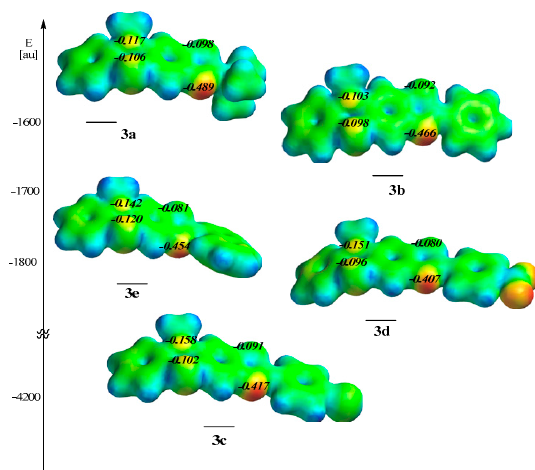
Figure 5. Molecular electrostatic potential surface (EPS) plots of TAPTZ 3a – e hierarchized in order of computed energy of the most stable conformer; blue colour on the surface represents highly positive potential regions, red colour represents highly negative potentials, while orange, yellow and green colours depict intermediate values of potential. Electrostatic charge is depicted on heteroatoms.